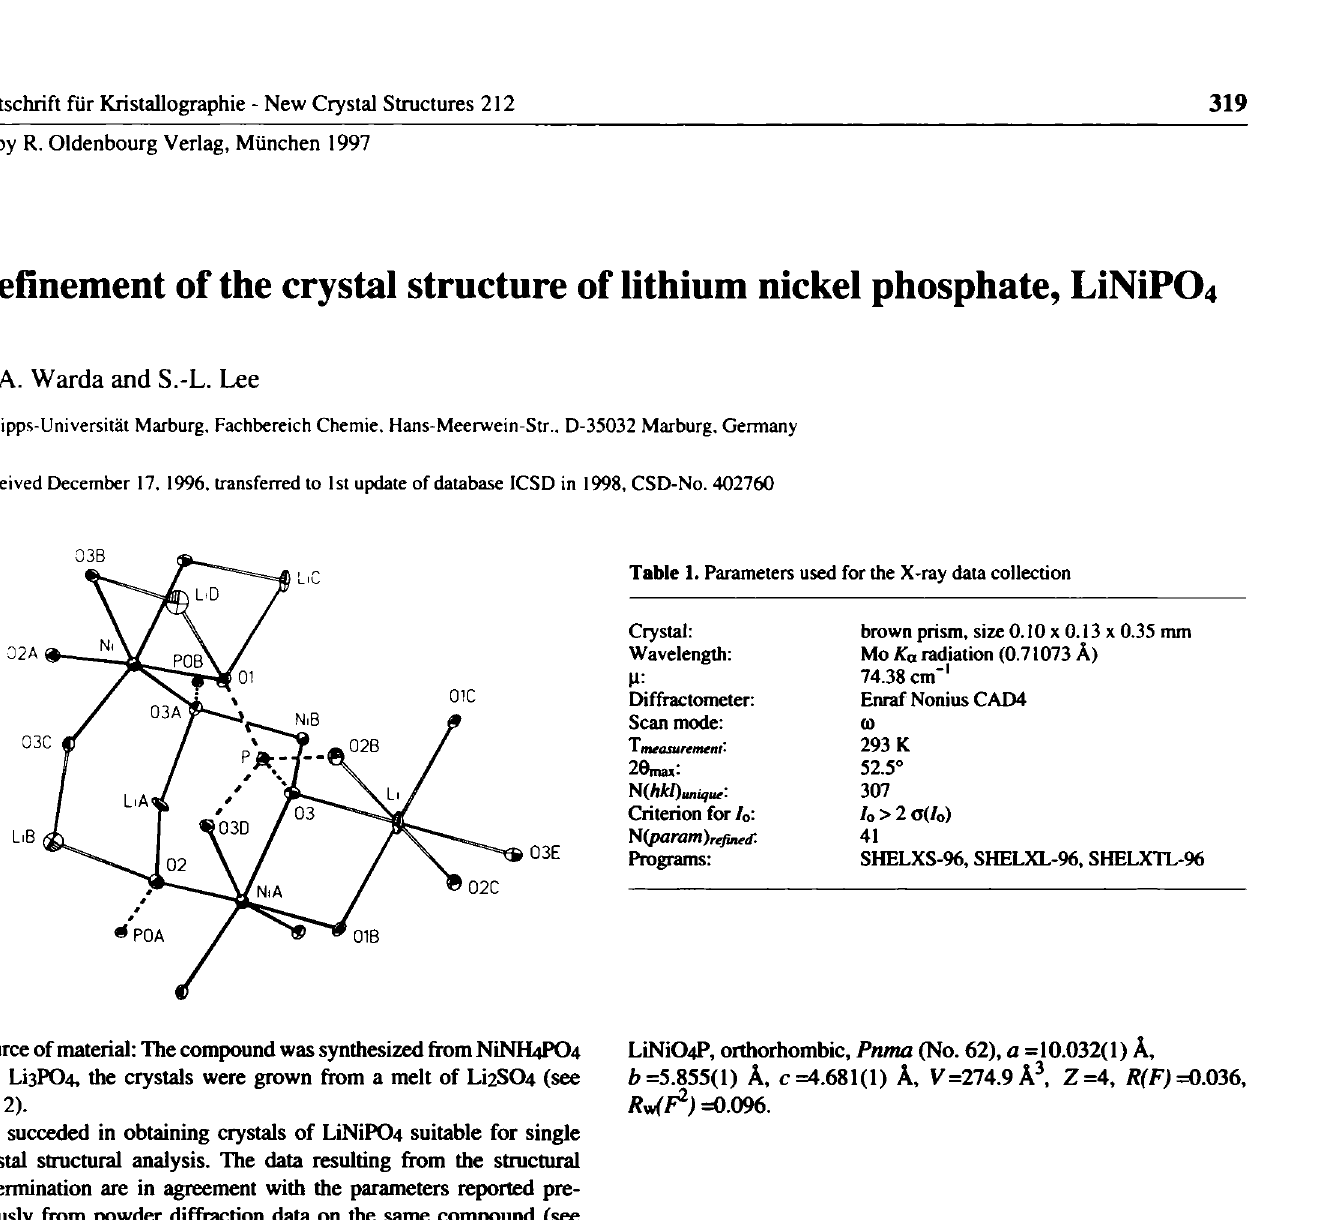
Table 2. Final atomic coordinates and displacement parameters (in Â 2